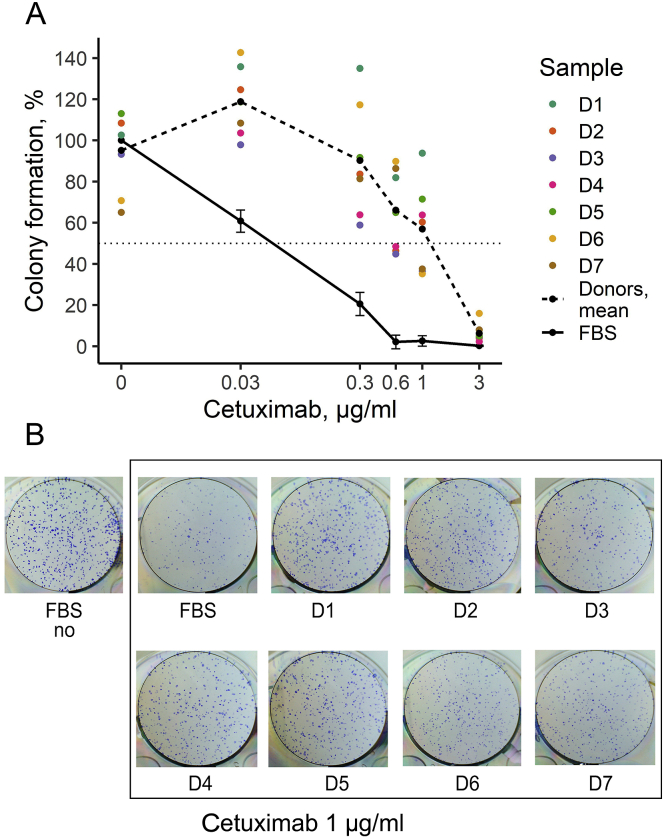
(A) A431 relative clonogenicity after treatment with cetuximab in the presence of human donor serum samples. Colored points represent average clonogenicity for each donor sample calculated from three replicates, D1-7 denotes the donor ID. The solid line (FBS) defines clonogenicity in the presence of FBS only; dotted line (mean) defines clonogenicity averaged for seven human donor samples. Colony formation is normalized to the results of the experiments with FBS-only growth media. (B). Representative photographs of stained clonogenicity assay wells, which were used for colony number calculations for 1 μg/ml cetuximab - treated cells.